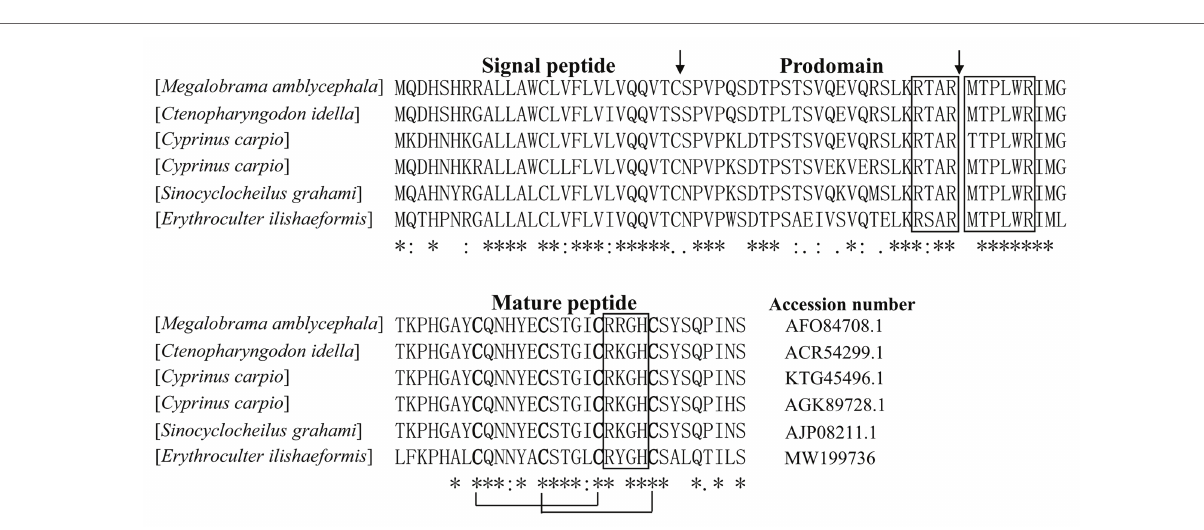
FIGURE 3 | Multiple alignment of the amino acid sequences of topmouth culter LEAP-2 and its homologues. The identical sites ( * ), conserved sites (:), and less conserved sites (.) were indicated in the multiple alignment of topmouth culter LEAP-2 with its homologues, the accession numbers of the selected homologues were listed following each sequence. The predicted cleavage site for the signal peptide and the cleavage site for mature peptide were marked with an arrow. The boxes indicated “RXXR,” “MTPLWR,” and “RXGH” motifs respectively. The four conserved cysteine residues in the mature peptide are bold. Two cysteine residues joined by a solid line represented a disulfide